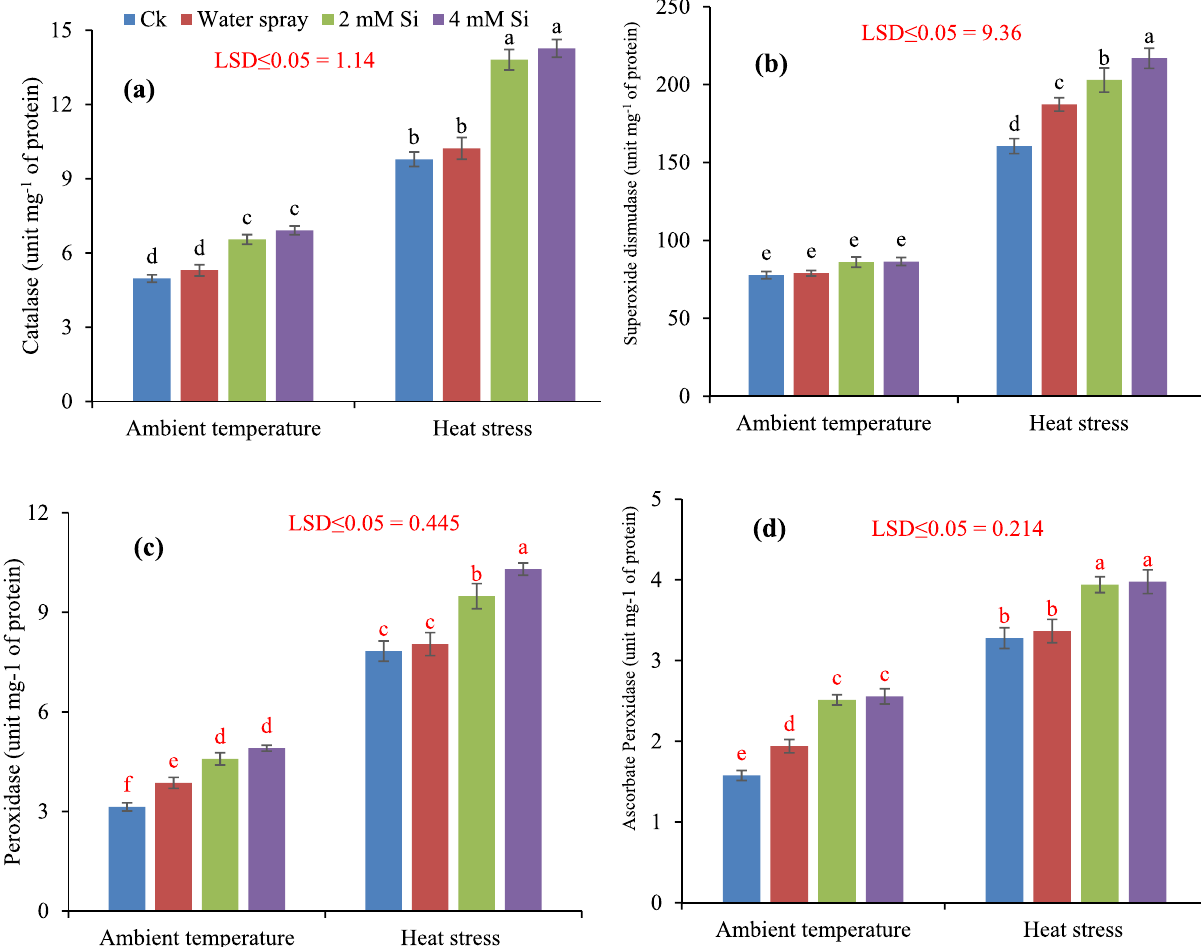
Figure 4. Influence of exogenously applied Si on catalase ( a ), superoxidase dismutase ( b ), peroxidase ( c ) and ascorbate peroxidase ( d ) of wheat under ambient temperature and heat stress. Values are the mean SE of four